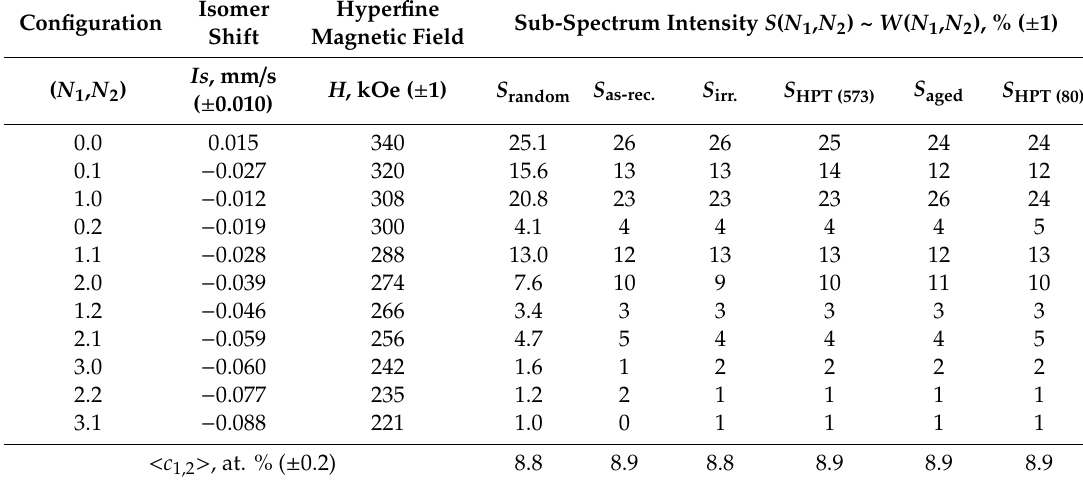
Table 3. Hyperfine Mössbauer parameters, intensities S ( N 1 , N 2 ) of subspectra and < c 1,2 > for the Fe 90.6 Cr 9.4 alloy in di ff erent states: S random –theoretical; S as-rec. –as received; S irr. –irradiated; S HPT (573) –HPT at 573 K; S aged –aged at 773 K, 50 h; S HPT (80) –aged and HPT at 80